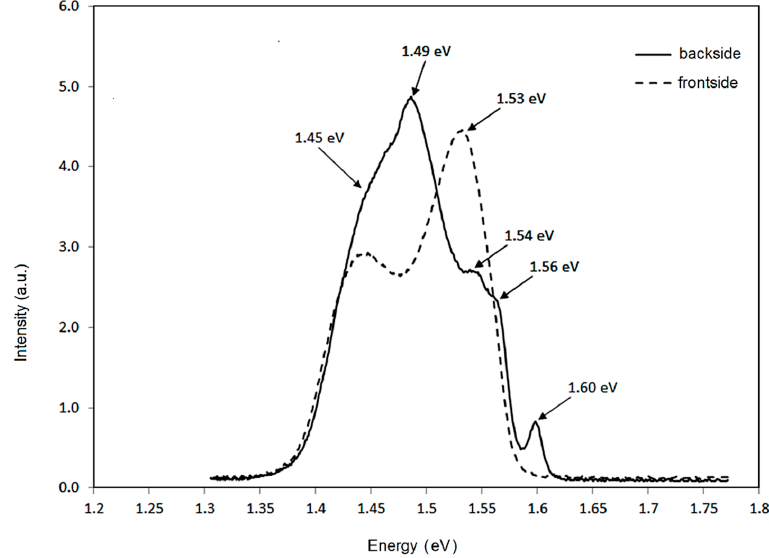
Figure 3. Photoluminescence (PL) spectra (10 K) from undoped CdS / CdTe solar cells excited from the backside (full line) and front side (dotted line) of the cell.